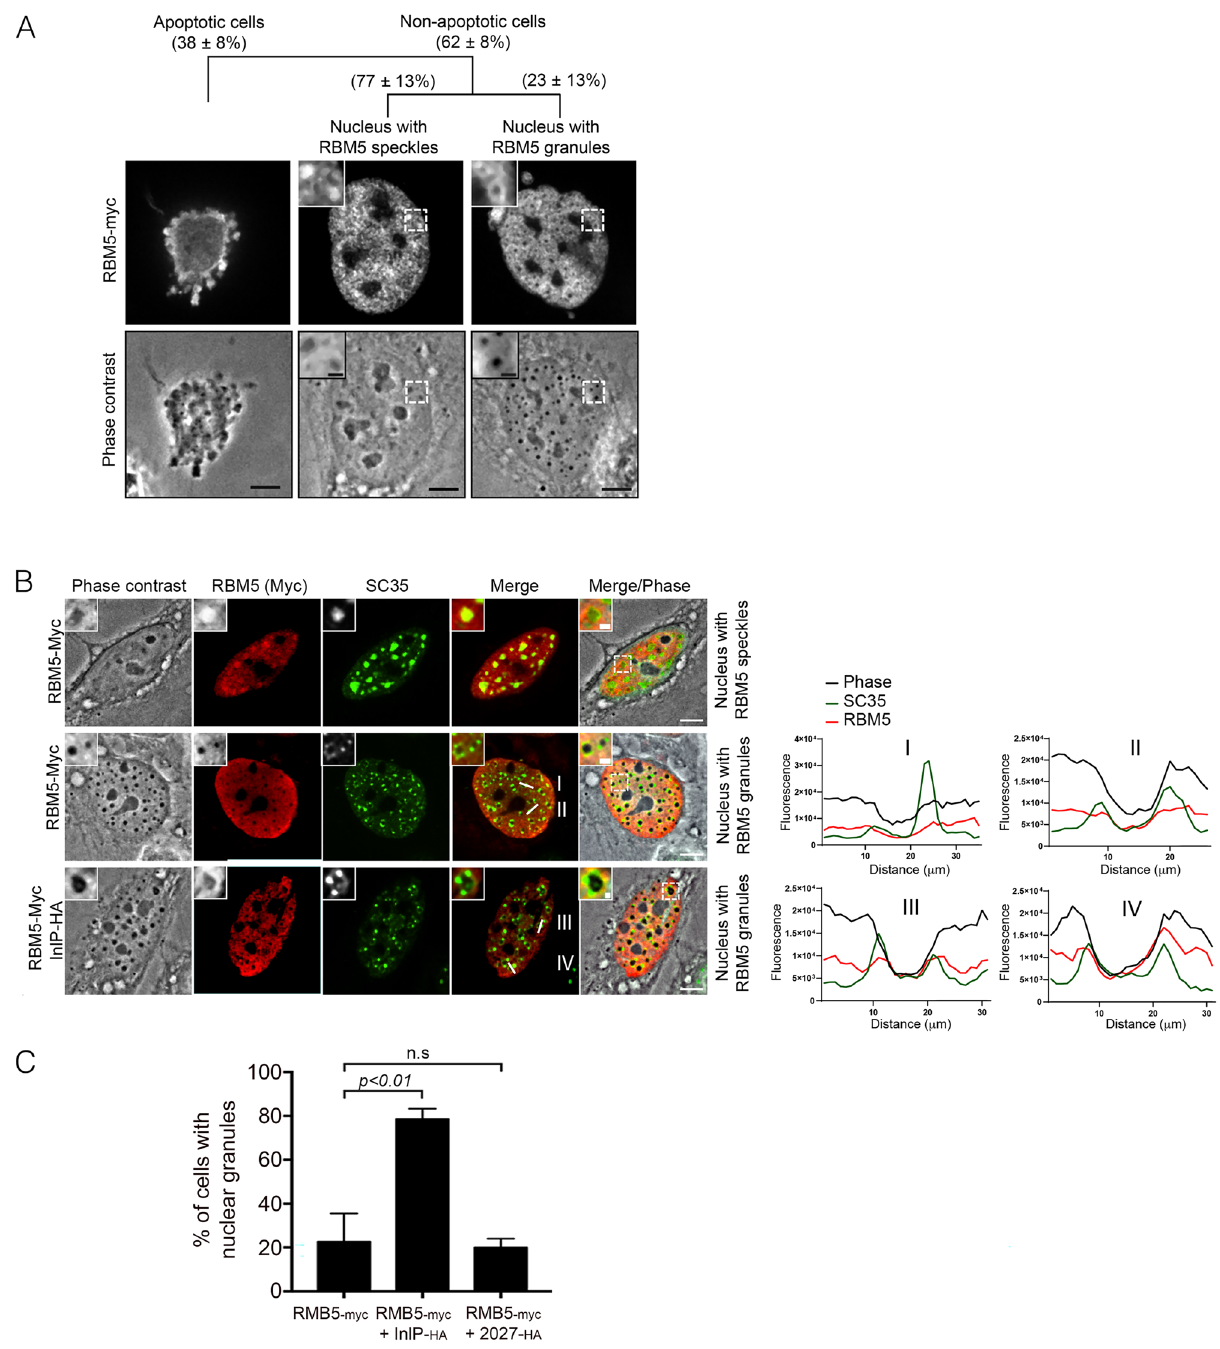
Figure 5. InlP stimulates formation of RBM5-associated nuclear granules. ( A ) Representative micrographs of the three subtypes of RBM5- Myc -expressing cells, with the RBM5- Myc immunostaining on top and the phase-contrast image below (bars: 10 µm). A higher magnification of each squared region is shown in the upper left corner (bars: 2 µM). The percentage of each cell subtype is indicated as a mean ± SD of 3 independent experiments, with n = 30 cells per replicate. ( B ) Left, representative phase contrast and immunofluorescence confocal microscopy images of transfected RBM5- Myc and SC35, in presence or absence of InlP- HA . Three subtypes of RBM5-expressing HeLa cells are shown: a cell with a nucleus containing RBM5-speckles (first row); a cell with a nucleus containing RBM5 granules (second row); a cell with a nucleus containing RBM5 granules in presence of InlP (third row). Scale bars: 10 µm. A higher magnification of each boxed region in the Merge/Phase image is shown in the upper left corner (Scale bars: 2 µm); Right, localization profile of RBM5 and SC35 assessed with a line scan (white lines in the merged images) whose fluorescence intensity is plotted in red for RBM5, in green for SC35 and in black for RBM5 granules; faint co-localization between RBM5 and SC35 is observed in I and II, while a more extensive colocalization is measured in III and IV. ( C ) Nuclei with RBM5 granules were scored in HeLa cells transfected RBM5- Myc or co-transfected with RBM5- Myc and InlP- HA or Lmo2027- HA . Histograms represent percentage of each category as mean ± SD of 3 independent experiments. Statistical significance determined by